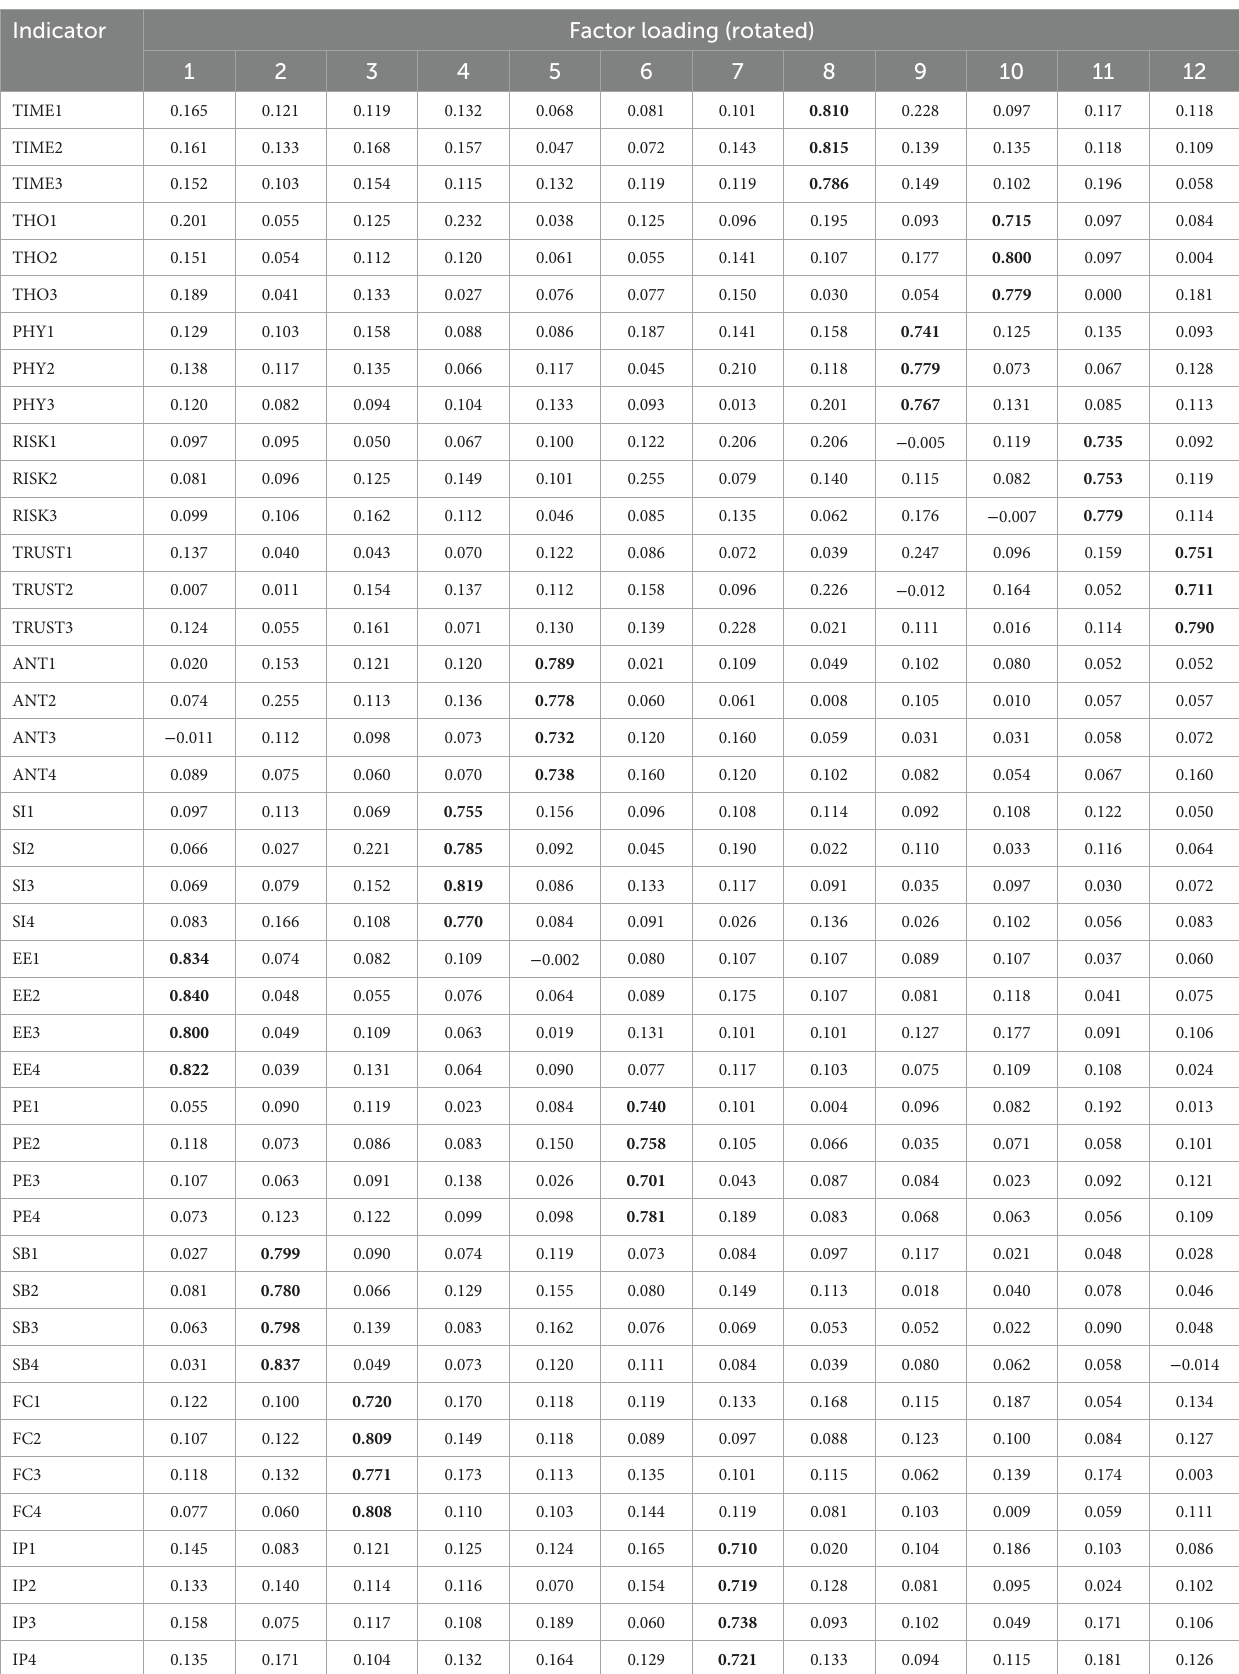
TABLE 3 The exploratory factor analysis results (component matrix).